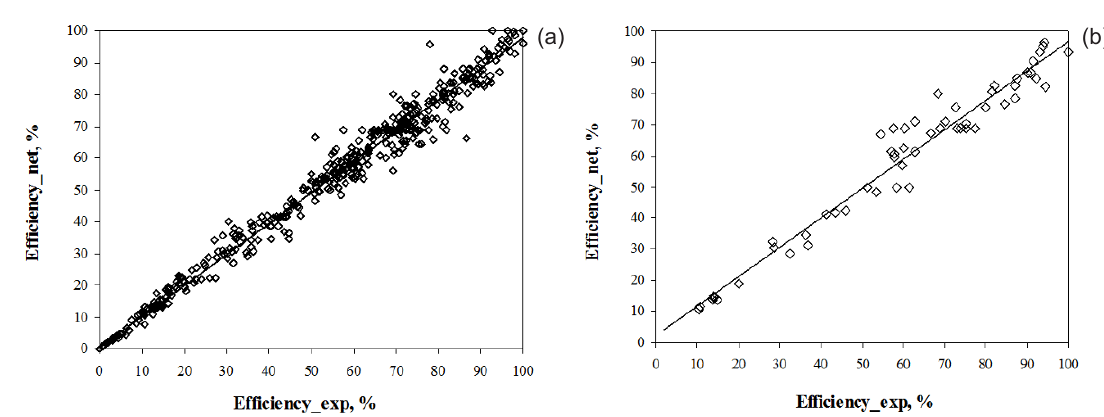
Figure 3. The efficiency of the process obtained experimentally and by neural network modeling, based on a heterogenous combination of the transfer functions, in the training (a) and testing (b) phases.